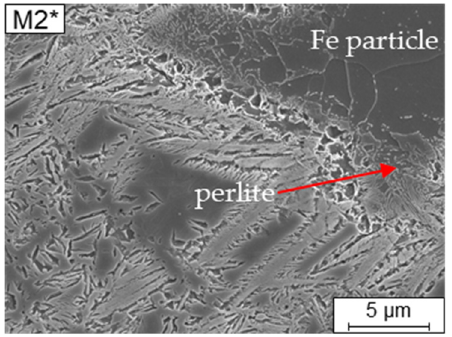
Figure 7. Incompletely molten Fe-particle in alloy M2* (SEM-SE).